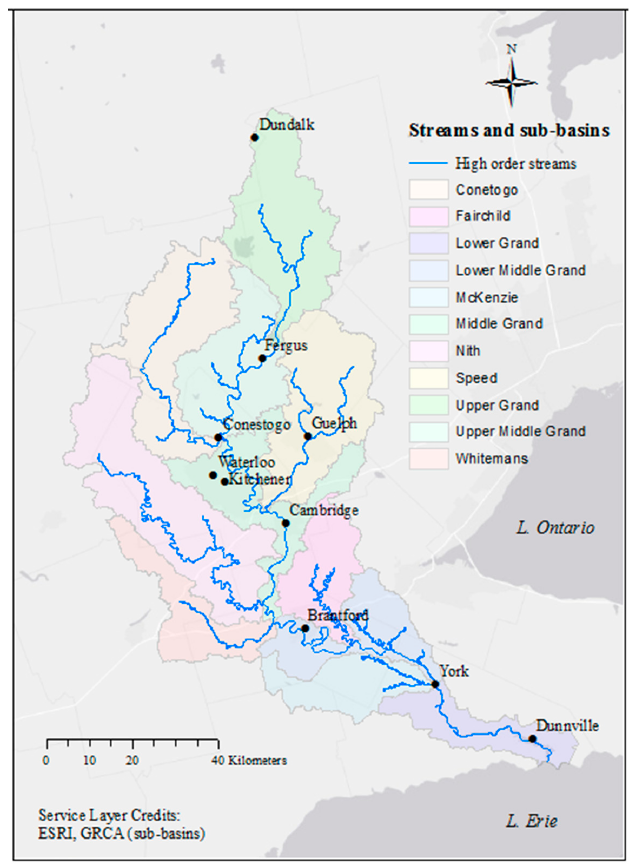
Figure 1. The Grand River watershed is located in Southwestern Ontario and drains into Lake Erie.